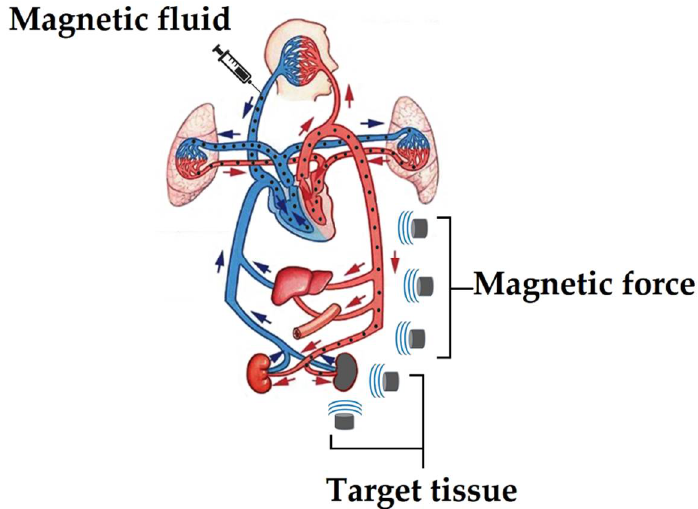
Figure 2. Pathway for a drug to reach a diseased part using MDDS.